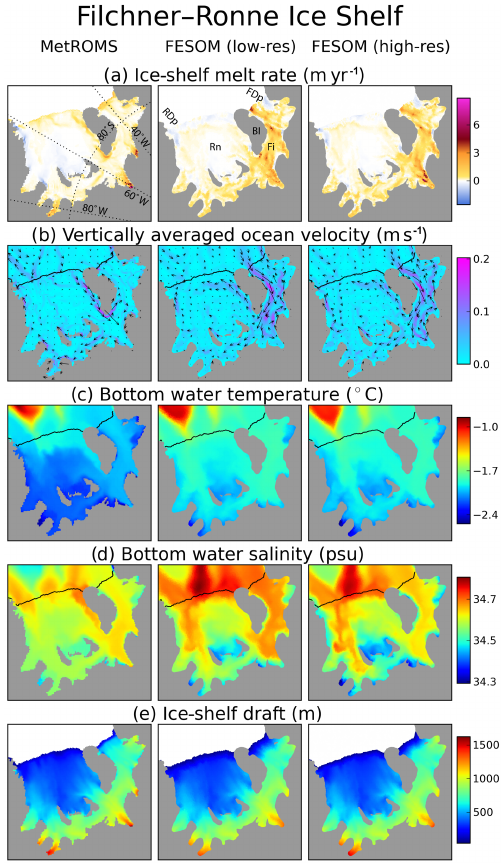
Figure 11. The Filchner–Ronne Ice Shelf cavity in MetROMS (left), low-resolution FESOM (middle), and high-resolution FE- SOM (right). All fields are averaged over the period 2002–2016. (a) Ice-shelf melt rate (myr − 1 ). (b) Vertically averaged ocean ve- locity (ms − 1 ), where the colour scale shows magnitude and the ar- rows show direction. (c) Bottom water temperature ( ◦ C). (d) Bot- tom water salinity (psu). (e) Ice-shelf draft (m) as seen by each model. In panels (b) – (d) , the ice-shelf front is contoured in black. Rn indicates Ronne Ice Shelf, Fi indicates Filchner Ice Shelf, RDp indicates Ronne Depression, FDp indicates Filchner Depression, and BI indicates Berkner